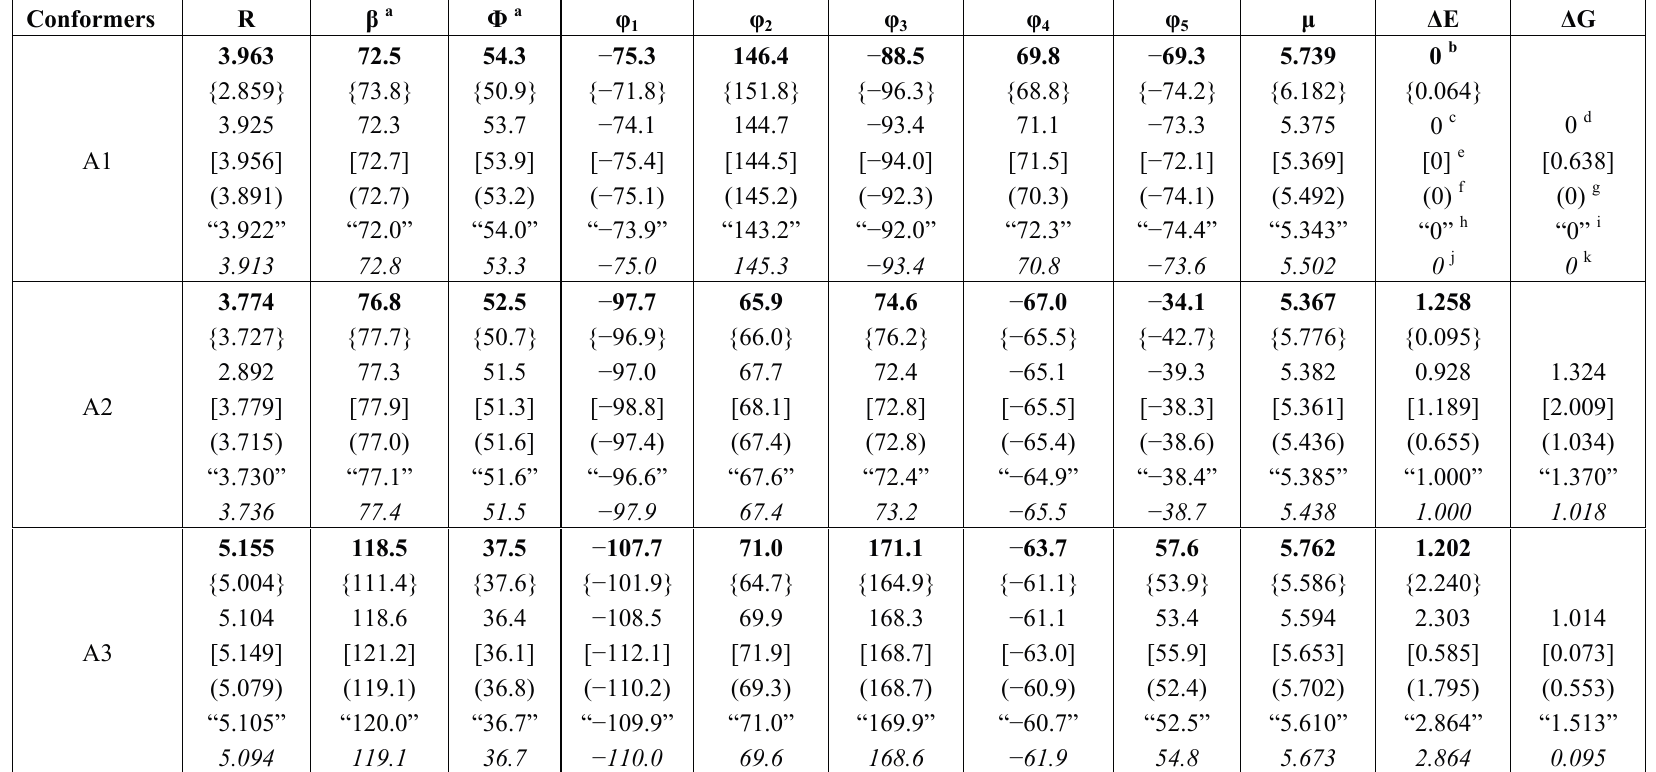
Table 2. The 78 optimum stable conformers calculated in tautomer N1 of acyclovir molecule at the levels: B3LYP/6-311++G(3df,pd) (values in bold); MP2/6-31G(d) (values in keys); B3LYP/6-31G(d,p) (values in normal type); O3LYP/6-31G(d,p) (values in brackets); B3PW91/6- 31G(d,p) (values in parenthesis); B3LYP/cc-pVDZ (values in quotation marks) and B972/6-31G(d,p) (values in italic type) level. Distance R in Å, torsional angles in degrees, dipole moments in debyes, and energy increments in kcal·mol − 1